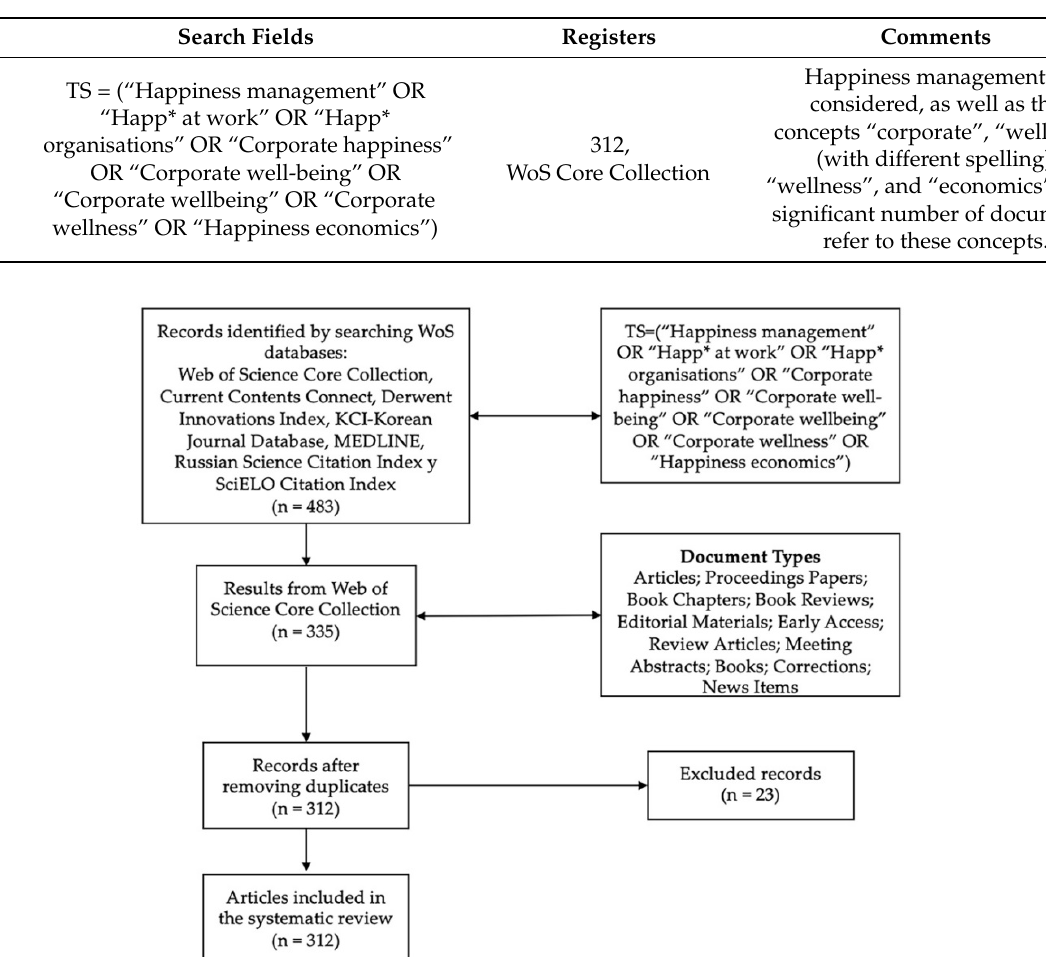
Figure 1. Flowchart of the bibliographic search and selection process. Table 1. Results of the WoS search for bibliometric analysis.